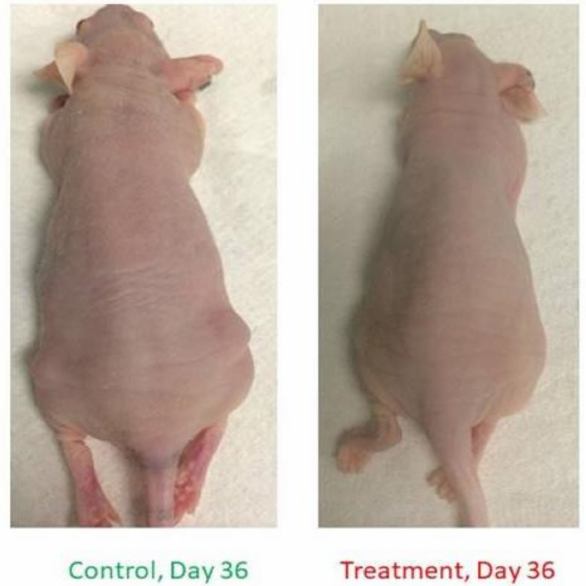
Figure 13. EAC cell xenograft growth inhibition by miR205HG in control and treatment mice. Notably, the mean tumor size in treatment group significantly smaller than control